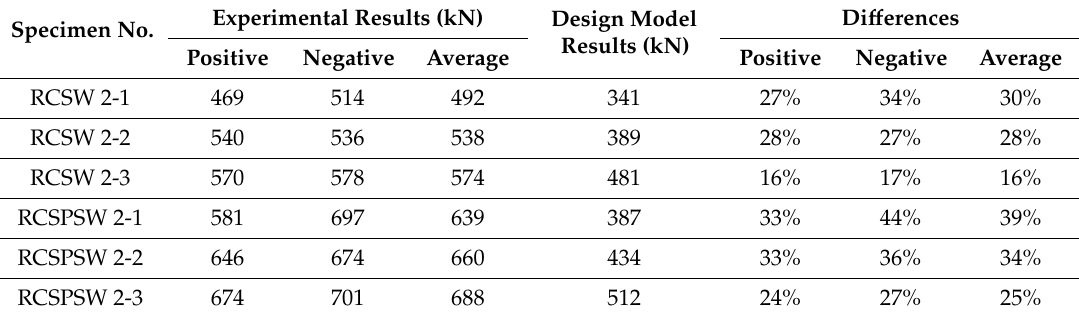
Table 8. Comparisons of Experimental and Design Strength Capacities for Flexure Specimens. Specimen No.